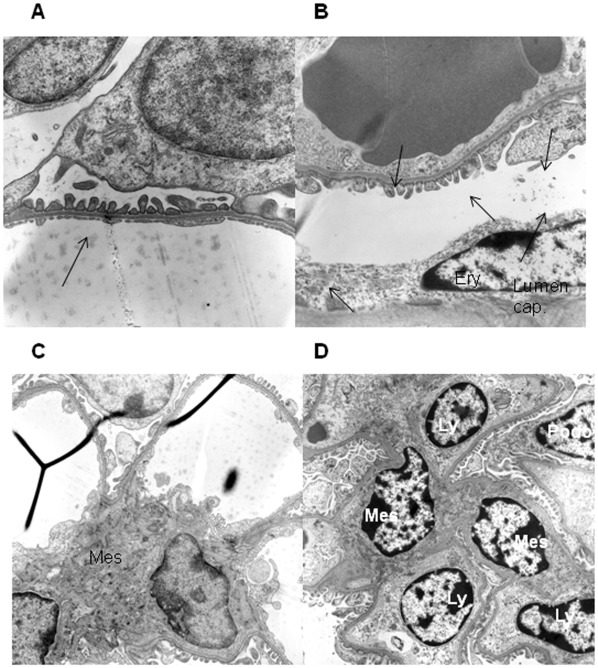
Glomerular endotheliosis and injury in CD73−/−mice.Electrone microscopic analysis was performed n = 7 CD73−/−mice vs. WT, original magnification x 10000 or 5000. (A) Ultrastructural analysis of the glomerular filtration barrier from a 3 months old WT mouse with regular appearance of foot processes and slit membranes and fenestration of the endothelium. (B) Analysis of the glomerular filtration barrier from a 3 months old CD73−/− mouse shows cytoplasmic swelling apparent in endothelial cells (cap. Lumen  =  capillary lumen, ery  =  erythrocyte), endothelial fenestrations and single foot effacements were reduced (arrow). No subepithelial depositis were detectable. (C) Overview of a glomerular segment with regular appearance and without glomerulitis (3 months old WT-mouse). (D) Overview of a glomerular segment in a 3 months old CD73−/−mouse (mes  =  mesangial cell, ly  =  lymphocytes) shows lymphocytic glomerulitis.